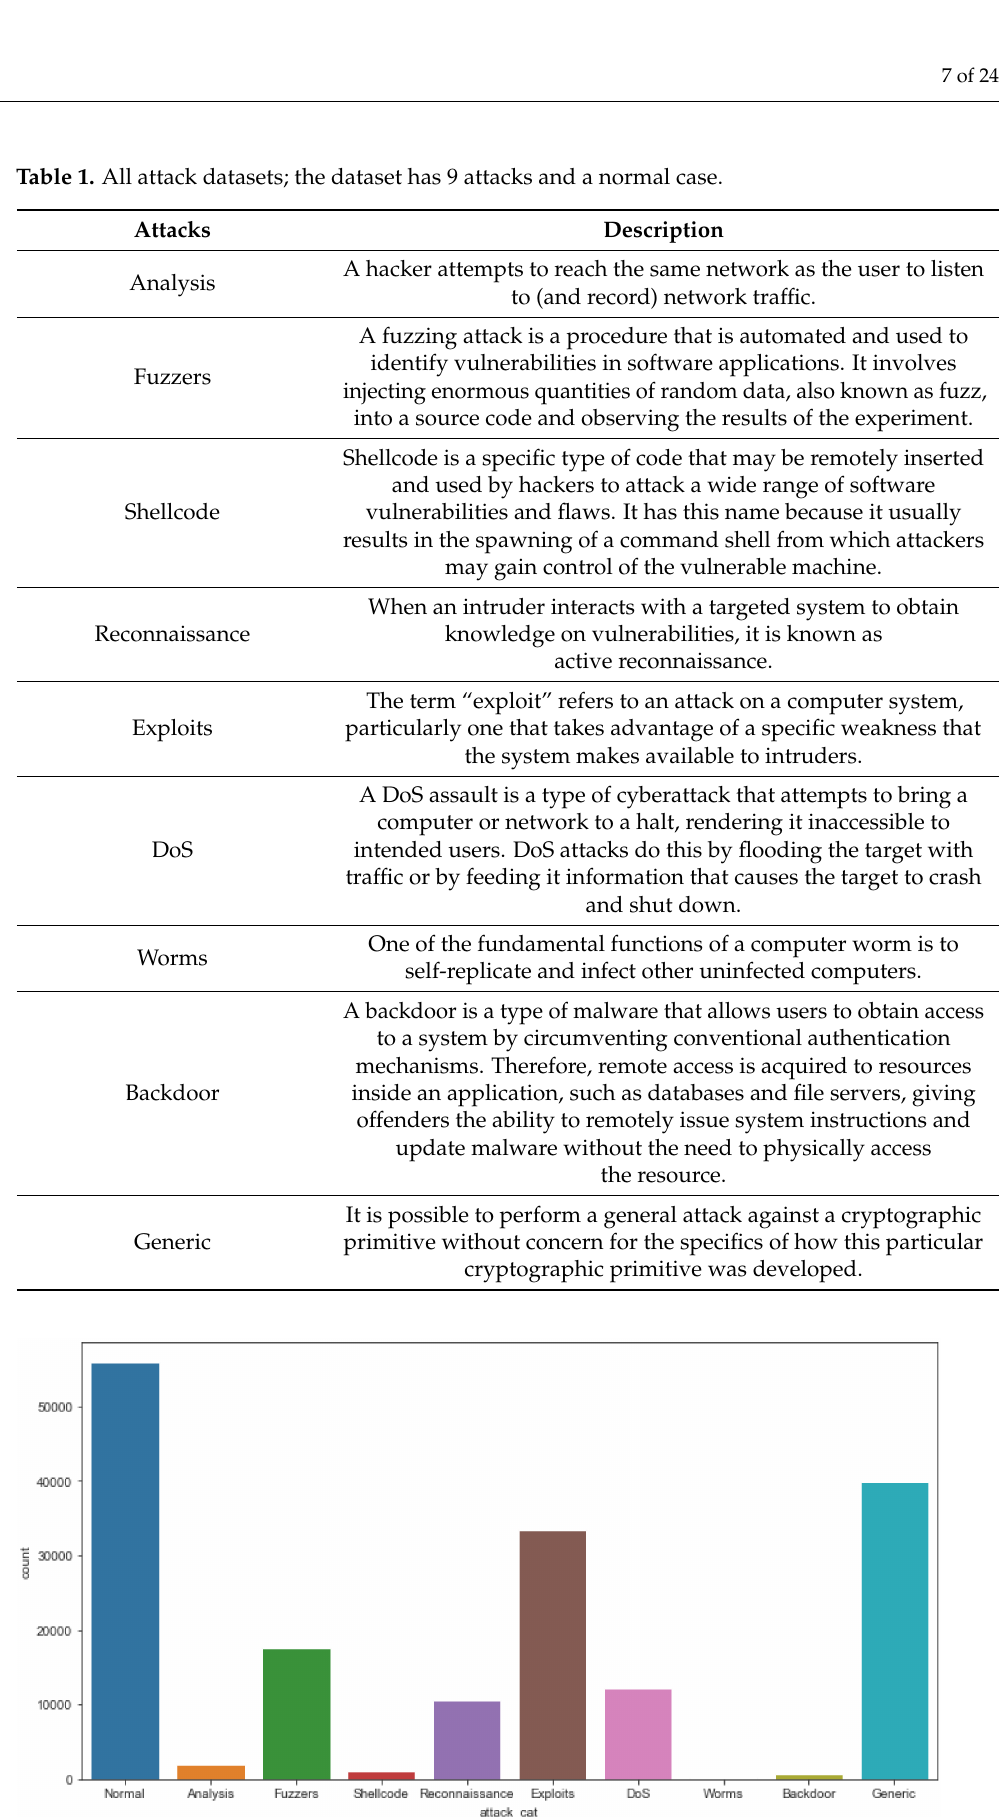
Figure 3. Volume of the dataset for each